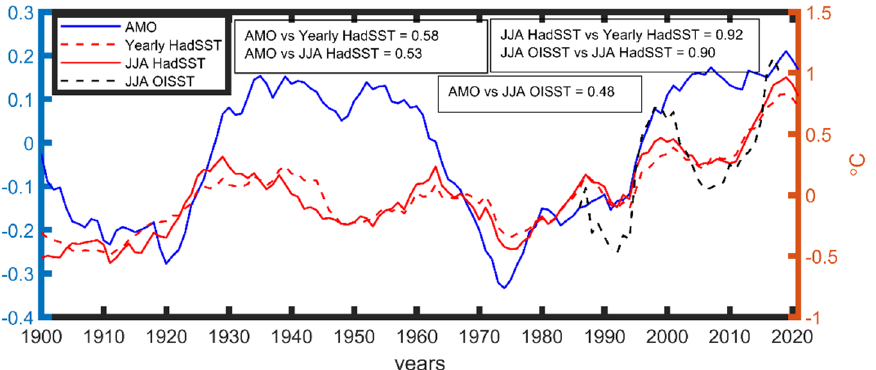
Figure 2. Time series of annual SST (dot red line), summer (solid red line), Atlantic multidecadal oscillation (AMO) (solid blue line) during 1900–2020, and OISST (dot black line) during 1982–2020, and their associated correlation analysis.